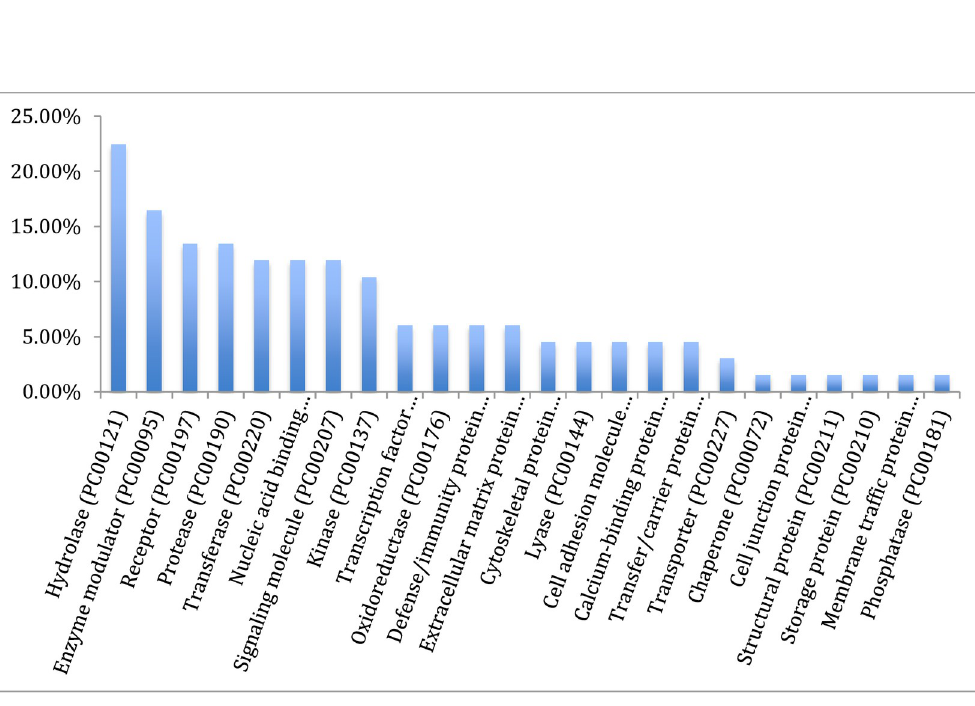
PLOS ONE | https://doi.org/10.1371/journal.pone.0225073 November18,